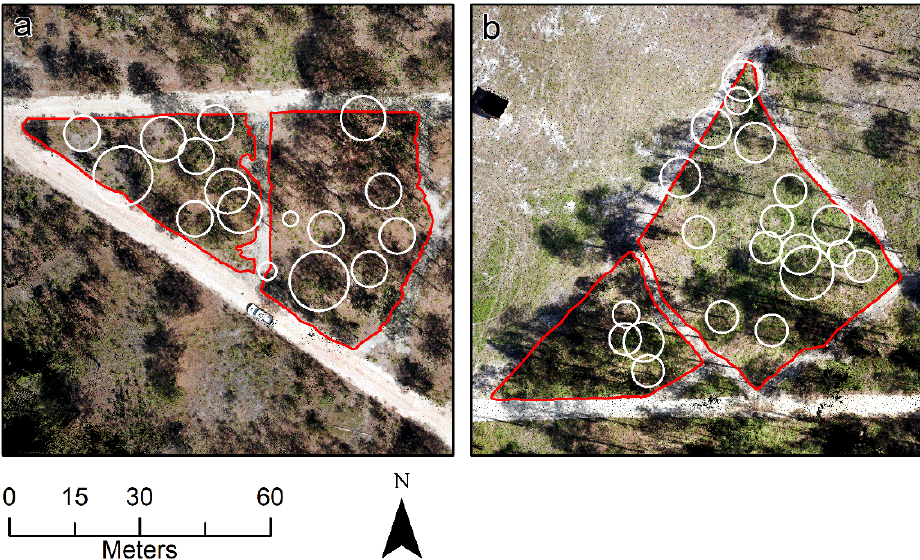
Figure 8. Buffered polygons, adjusted for overlap, representing ground truth estimates of sparkle- berry cover distributions for burn units ( a ) 24A and ( b ) 24B. Portions of polygons extending outside a burn unit were truncated at the boundary.